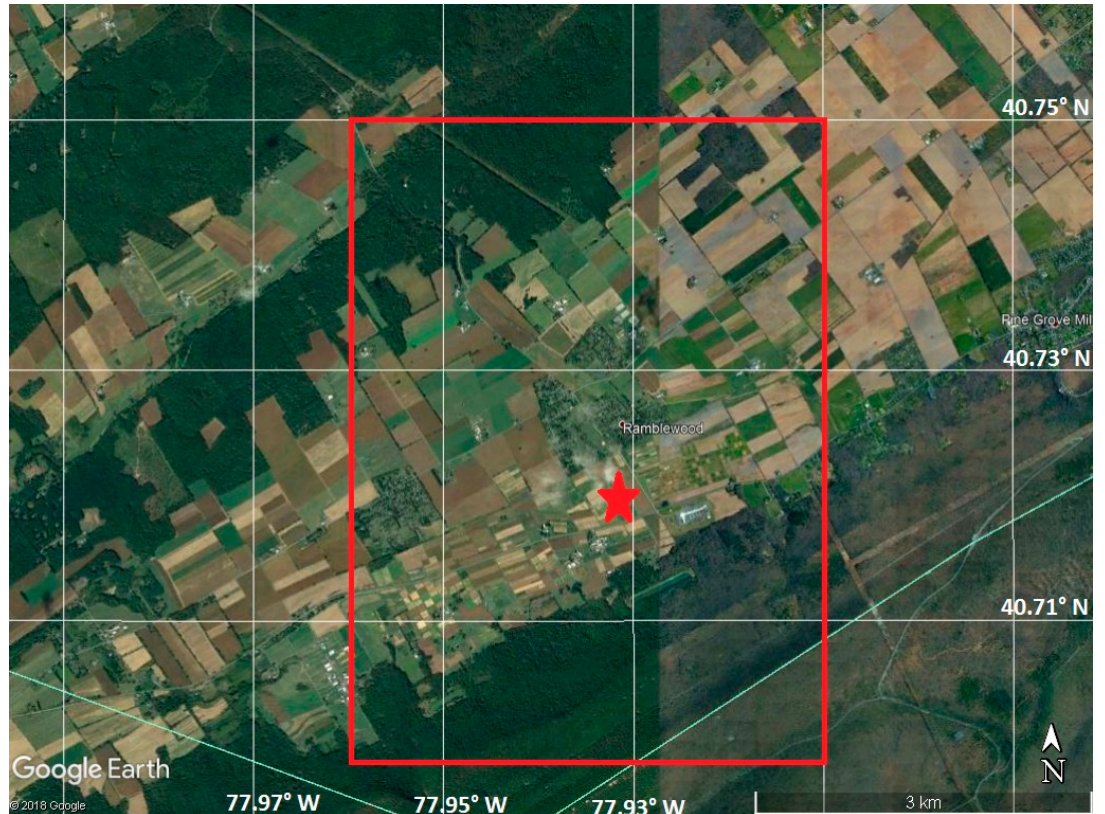
Figure 6. Google Earth true-colour satellite image of the area around Pennsylvania State University (PSU) station. The inserted red star indicates the location of PSU station and the red rectangle gives the nominal position of the pixel used for validation. The white lines are lines of constant latitude or longitude.